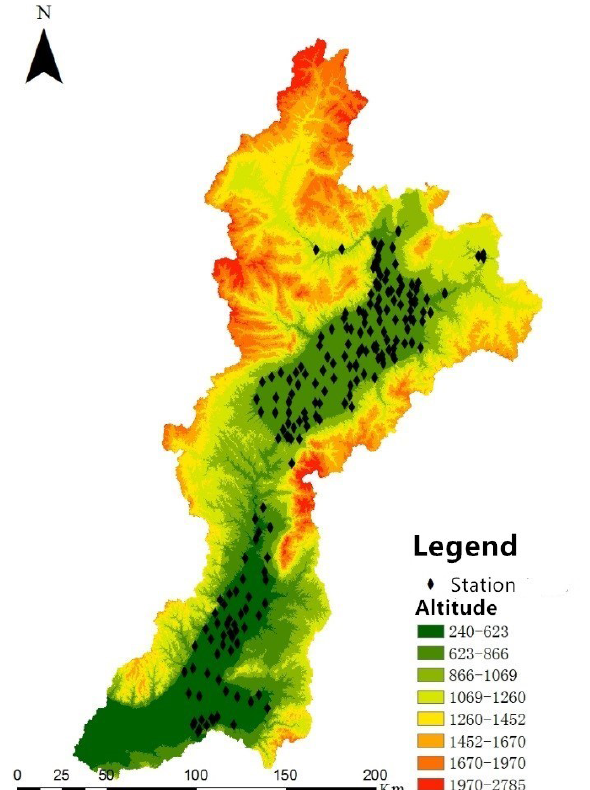
Figure 2. Distribution of Groundwater Level and Buried Survey in Fenhe River